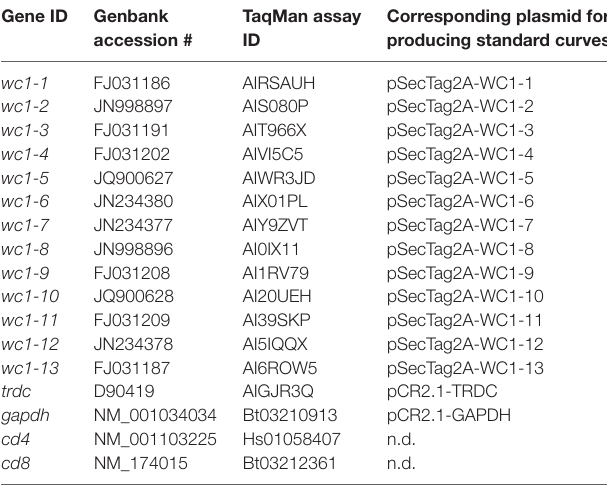
Table 1 | TaqMan primer/probe